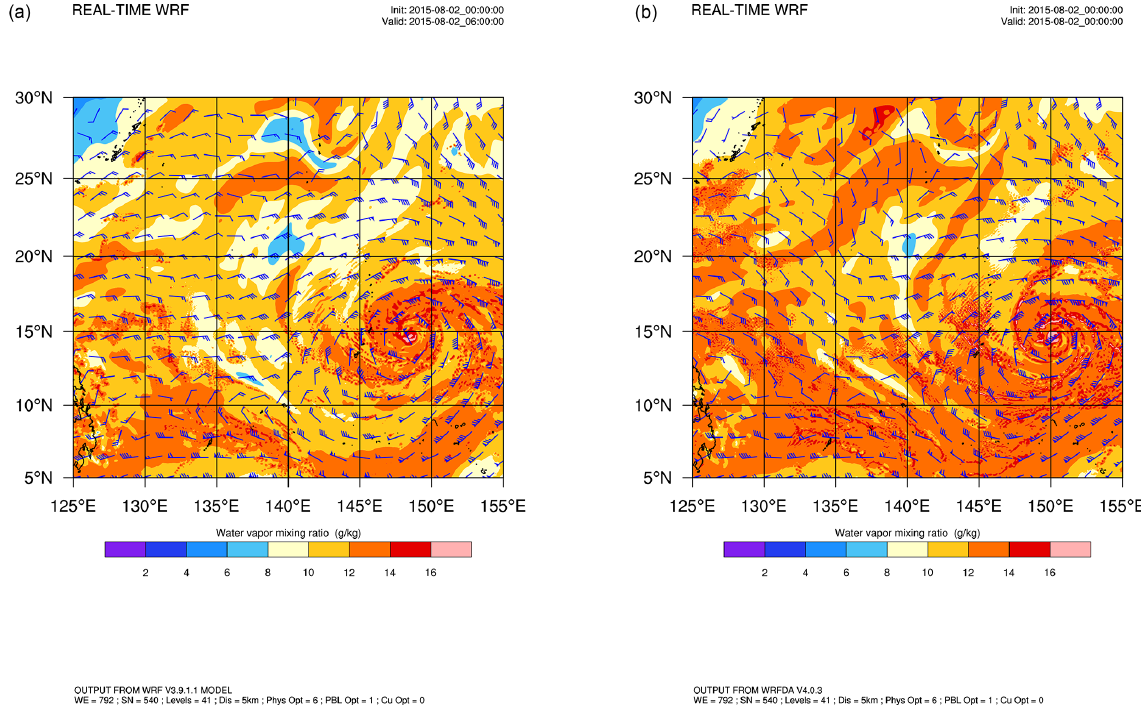
Figure 11. The surface wind speed (vectors; unit: ms − 1 ) and water vapor (colored; unit: gkg − 1 ) for (a) CTNL and (b) AHI_DA at 850hPa at 00:00UTC on 2 August